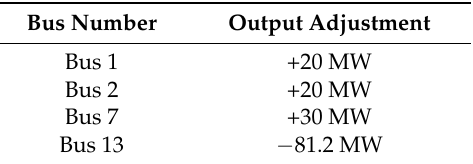
Table 7. The output adjustment of generators.